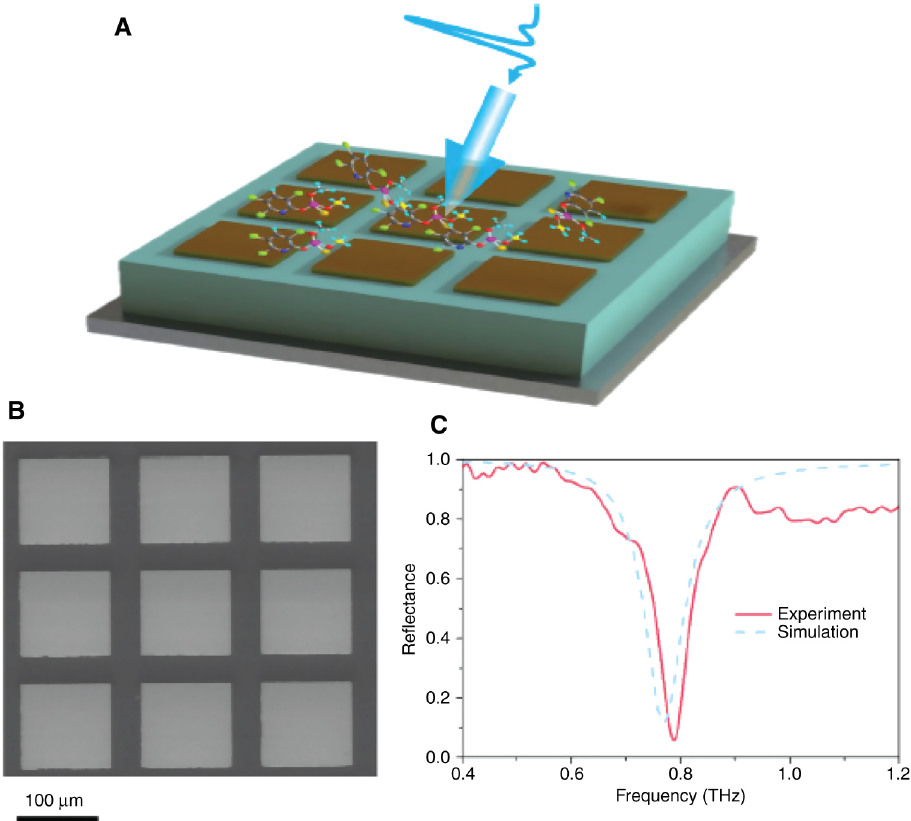
Figure 5: (A) Schematic diagram of THz metamaterials detection of CM. (B) A scanning electron microscope (SEM) image of the THz metamaterials; the metal patch length is 105 μ m and the period of the metamaterials is 140 μ m. (C) Reflectance curves of simulation and experimental results of THz metamaterials